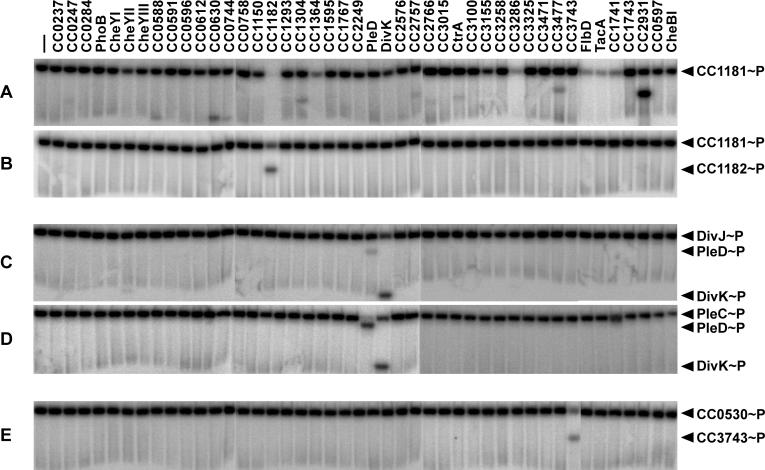
Phosphotransfer Profiling of C. crescentus Histidine KinasesProfiles for four purified C. crescentus kinases versus 44 purified response regulators were obtained by the method described for E. coli in Figure 4.(A) One-hour time point profile of the C. crescentus kinase CC1181.(B) Ten-second time point profile. Only CC1182, encoded in the same operon as CC1181 and the likely in vivo target, is phosphorylated at the short time point. Kinetic preference of C. crescentus histidine kinases for their cognate substrates was similarly demonstrated for five other operon pairs (data not shown).(C and D) Ten-second time point profiles of the orphan kinases DivJ and PleC, demonstrating phosphorylation of only their shared in vivo targets, PleD and DivK.(E) Phosphotransfer profiling of the previously uncharacterized essential orphan kinase CC0530 (CenK) reveals a single preferred substrate, CC3743 (CenR).